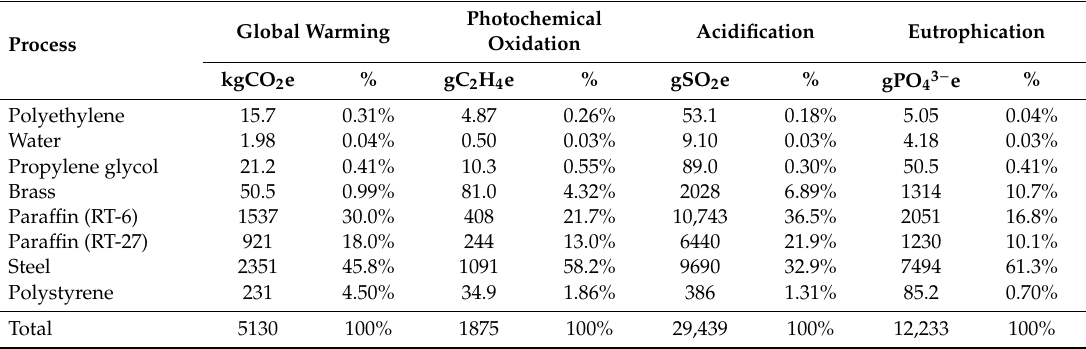
Table 9. Details of the